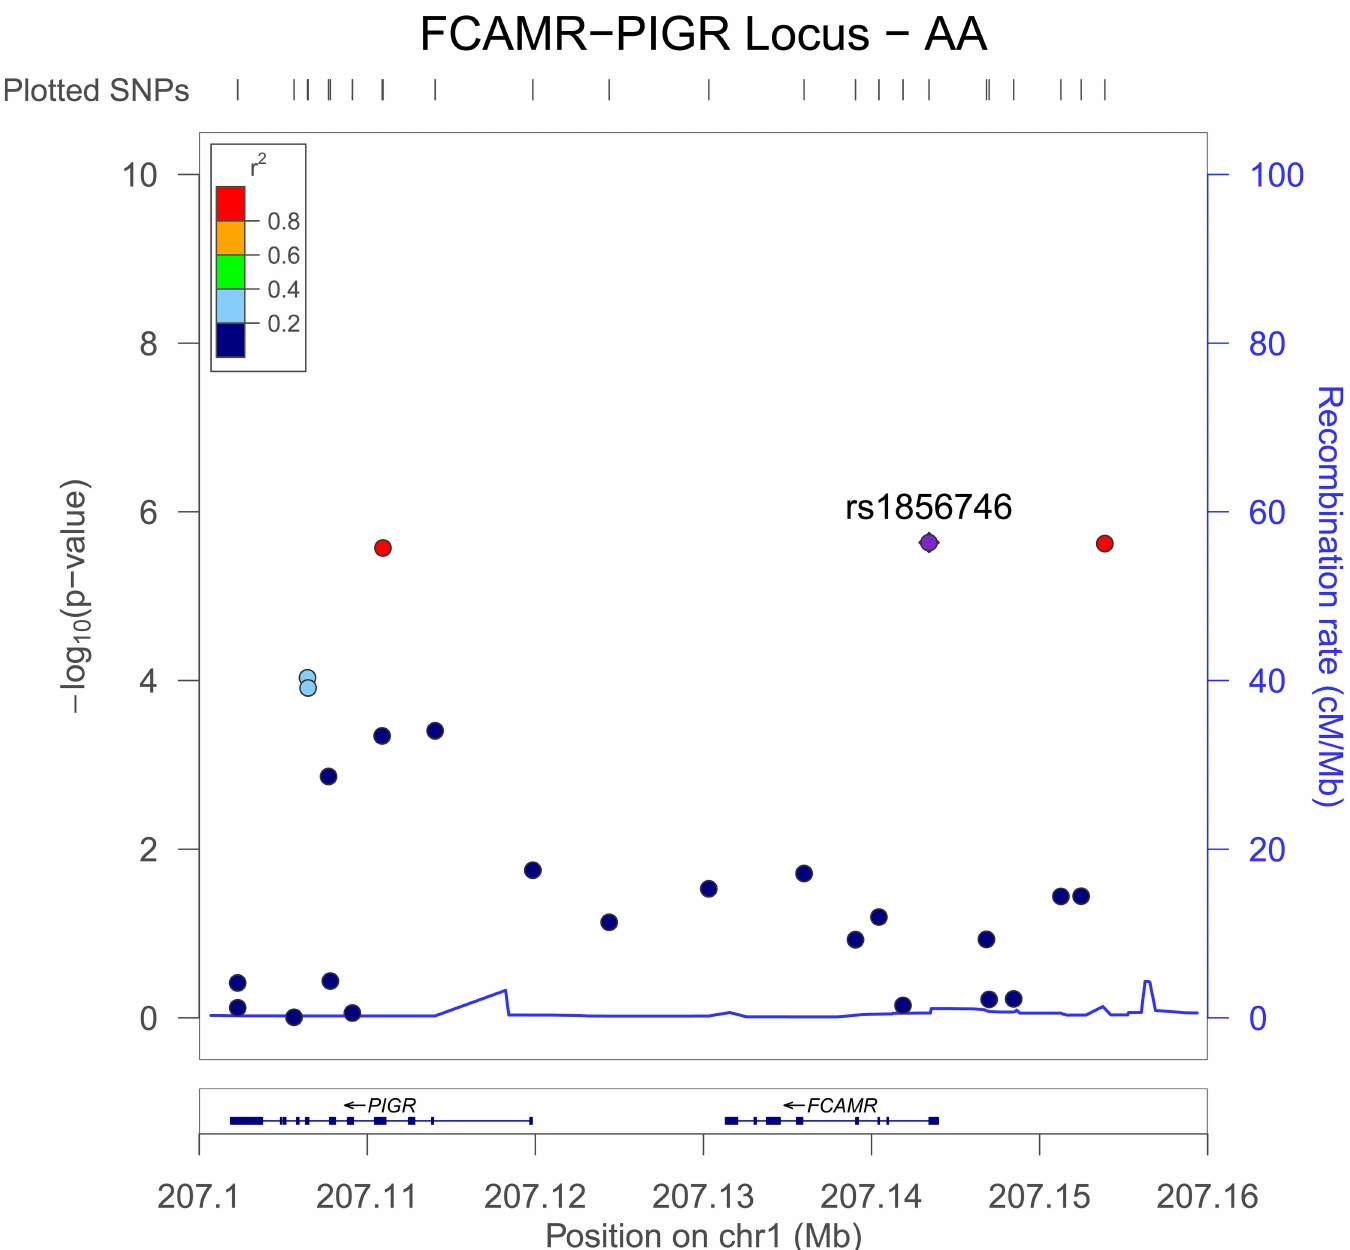
Fig 5. LocusZoom Plot of FCAMR-PIGR locus for African-Americans. LD is calculatedrelativeto the most significantvariant rs1856746. LD across the three most significantvariants within the regionis substantialhowever all other variants in the regionshow little correlationwith rs291096despitethe relatively low recombination rate across the region. For plotting 1000 Genomes data is used (populationAFR) in genome build hg19.